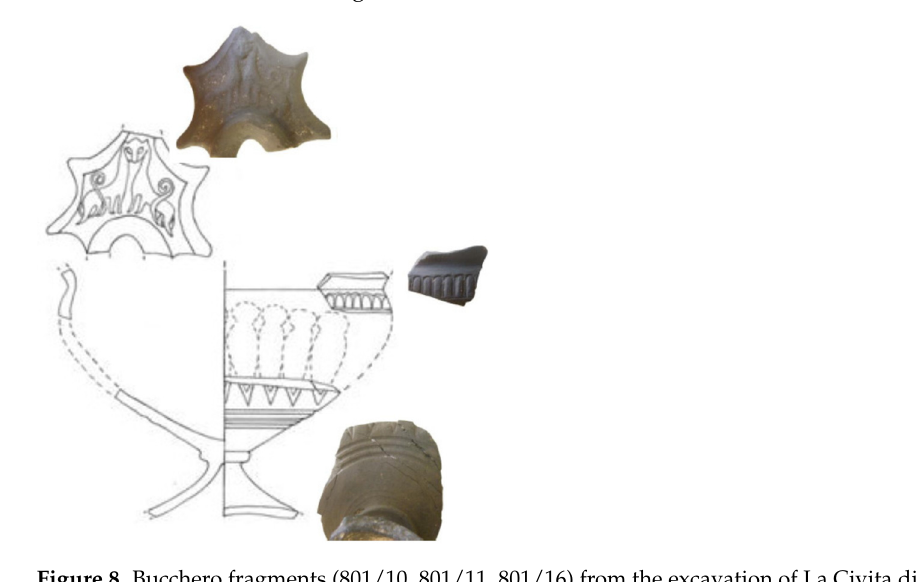
Figure 8. Bucchero fragments (801/10, 801/11, 801/16) from the excavation of La Civita di Tarquinia, belonging to the same “kyathos” (see text), and the virtual reconstruction of the vase.